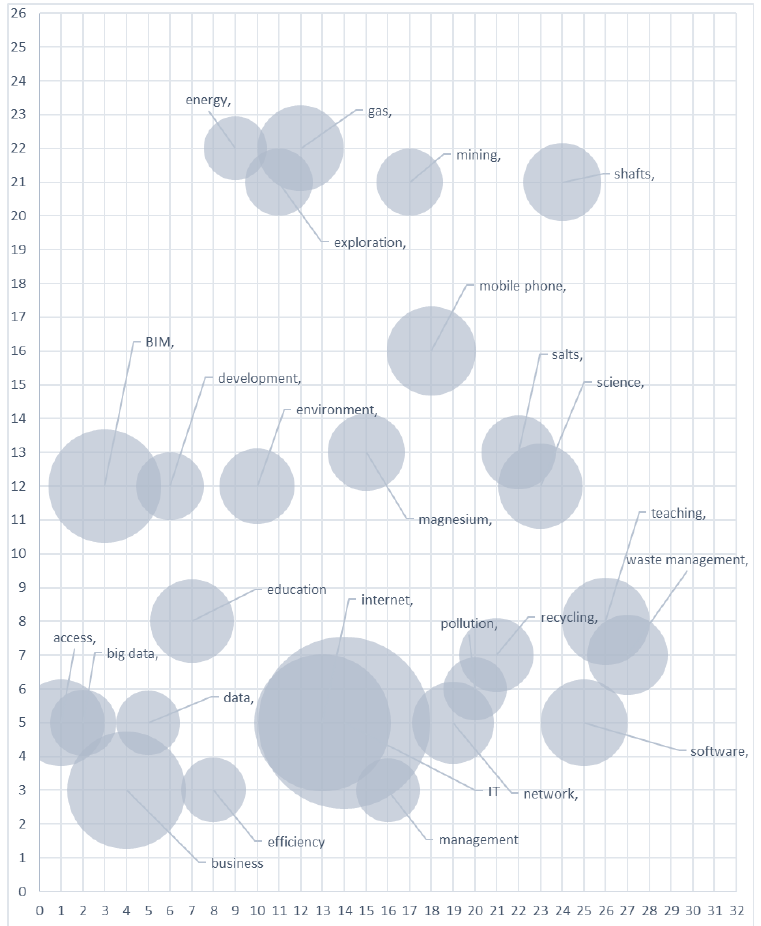
Figure 4. Map of market gaps diagnosed in the raw materials industry in Poland (own study).